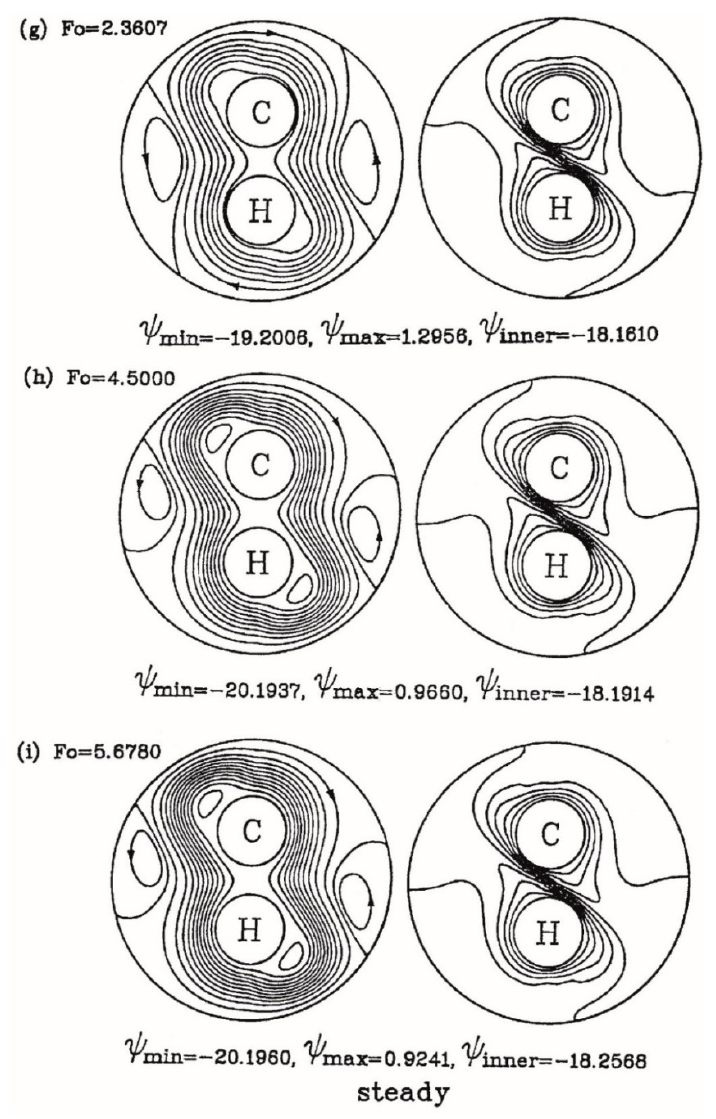
Figure 4. Transient variations in streamlines ( left ) and isotherms ( right ) ( φ g = − 90 ◦ , Ra = 10 4 and s / d = 0.7).